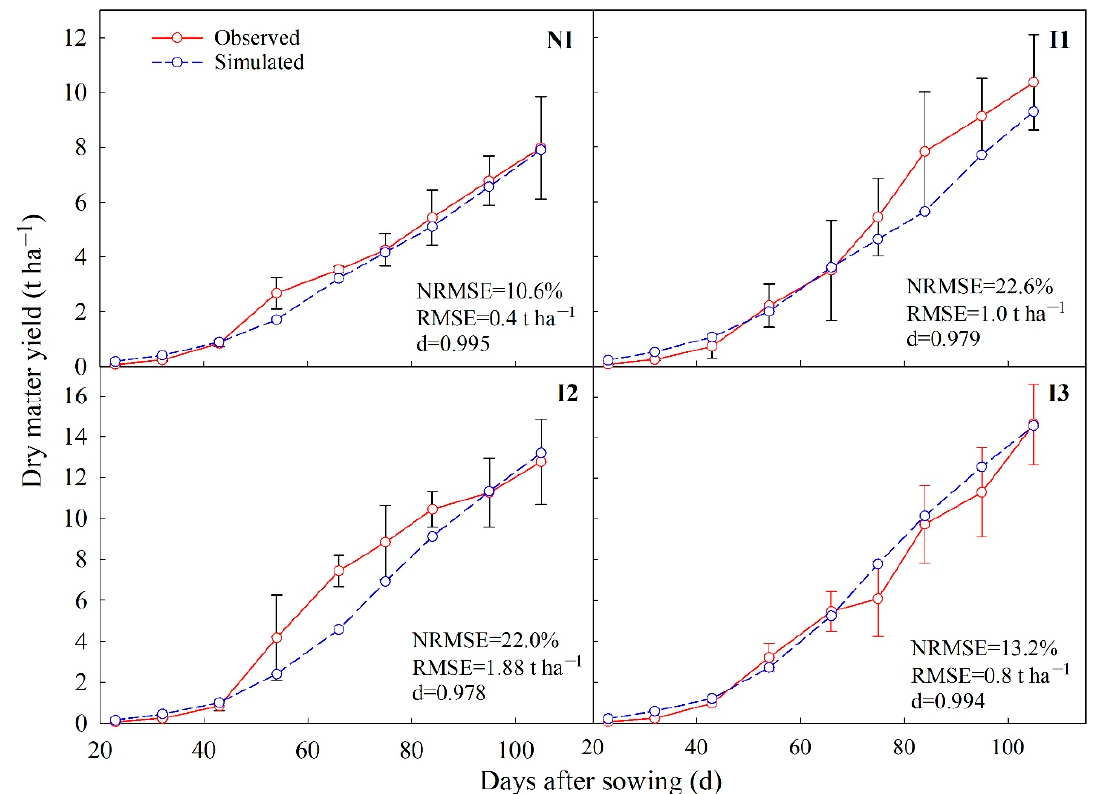
Figure 5. Comparison of observed (solid lines) and simulated (dotted lines) dry matter yield of oat in model validation. Experiment data under high nitrogen in 2018 were used. I1 —irrigation only at flowering; I2 —irrigation at tillering and jointing; I3 —irrigation at tillering, jointing, and flowering. Error bars indicate one standard deviation from the observed mean.